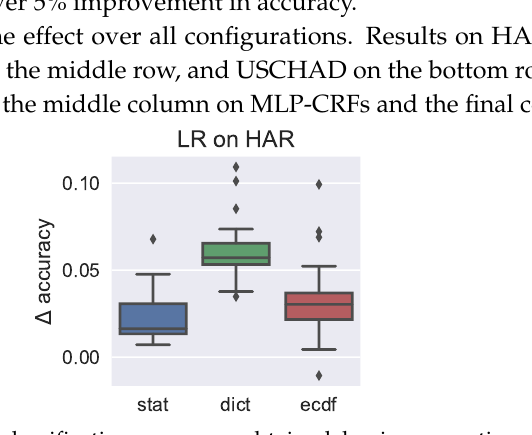
Figure 8. Improvement in classification accuracy obtained by incorporating structure on the classification task with Conditional Random Fields